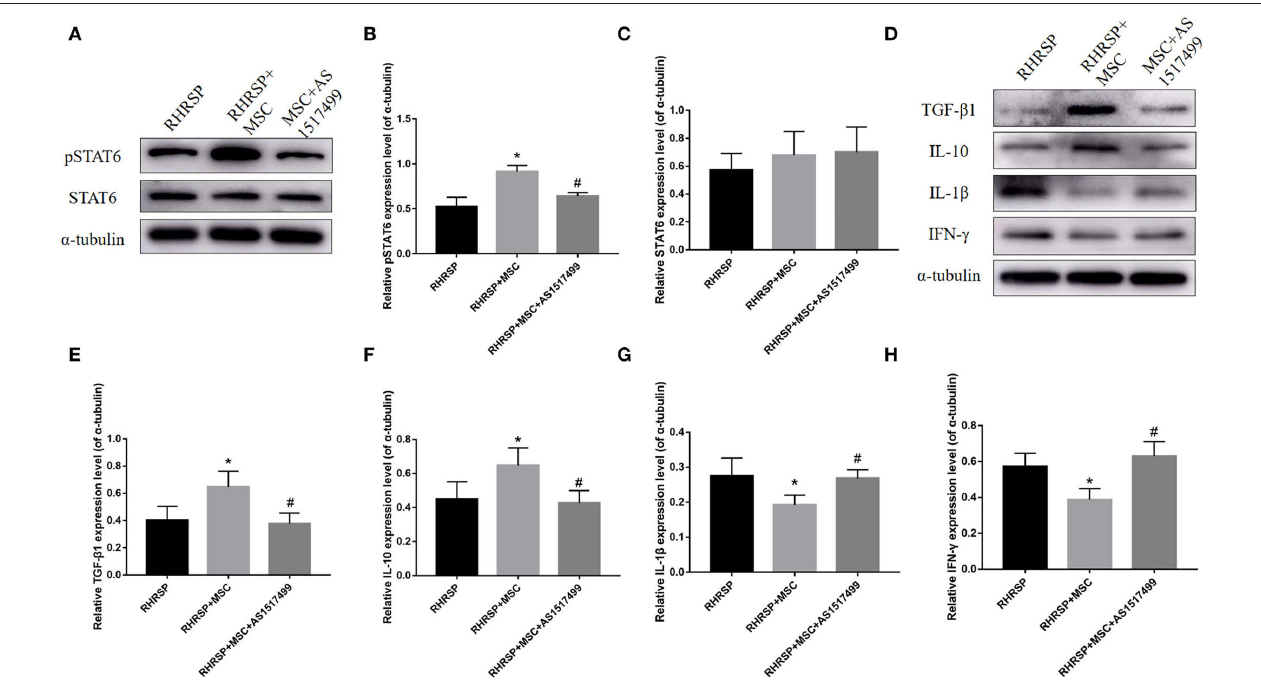
FIGURE 10 | Effects of AS1517499 on the expression of STAT6, pSTAT6 and cytokines in the hippocampus after AS1517499 acquisition. (A) Representative images of western blot analysis of STAT6, pSTAT6 and α -tubulin. (B,C) Quantification of the relative protein expression levels of STAT6 and pSTAT6. (D) Representative images of western blot analysis of cytokines in the hippocampus in three groups after AS1517499 acquisition. (E–H) Quantification of the relative protein expression levels of TGF- β 1, IL-10, IL-1 β and IFN- γ . (* P < 0.05, vs. sham-operated group, # P < 0.05, vs. RHRSP group; n =